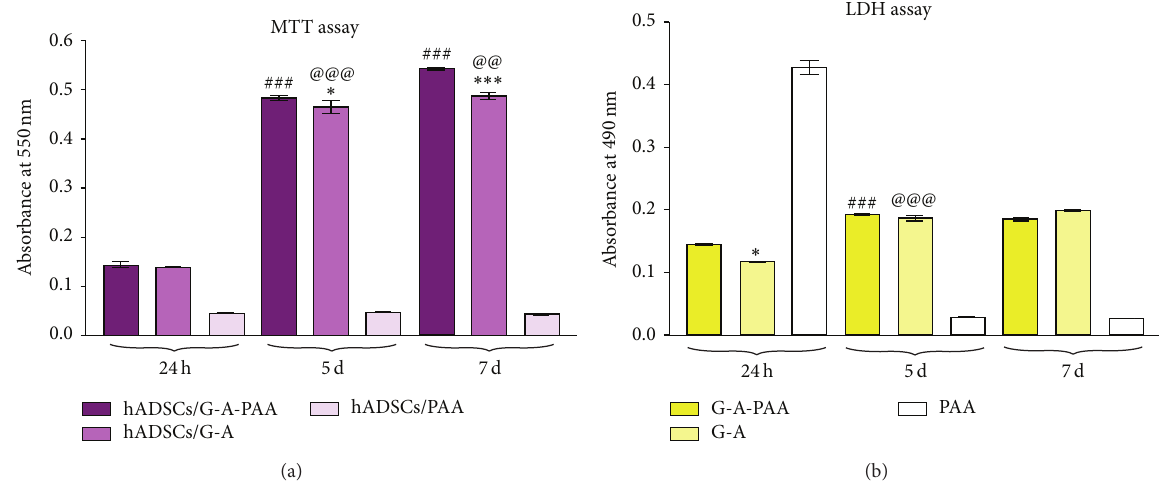
Figure 6: The quantification of (a) hADSCs proliferation rate in G-A-PAA, G-A, and PAA biomatrices, as revealed by MTT test and (b) the cytotoxic potential of G-A-PAA, G-A, and PAA biomatrices on hADSCs as revealed by LDH assay, at 24 h, 5 days, and 7 days. ( ∗ 𝑃 < 0.05 (hADSCs/G-A-PAA versus hADSCs/G-A bioconstruct); ∗∗∗ 𝑃 < 0.001 (hADSCs/G-A-PAA versus hADSCs/G-A bioconstruct); ### 𝑃 < 0.001 (hADSCs/G-A-PAA: 5 days versus 24 h days and 7 days versus 5 days); @@ 𝑃 < 0.01 (hADSCs/G-A: 7 days versus 5 days); @@@ 𝑃 < 0.001 (hADSCs/G-A: 5 days versus 24